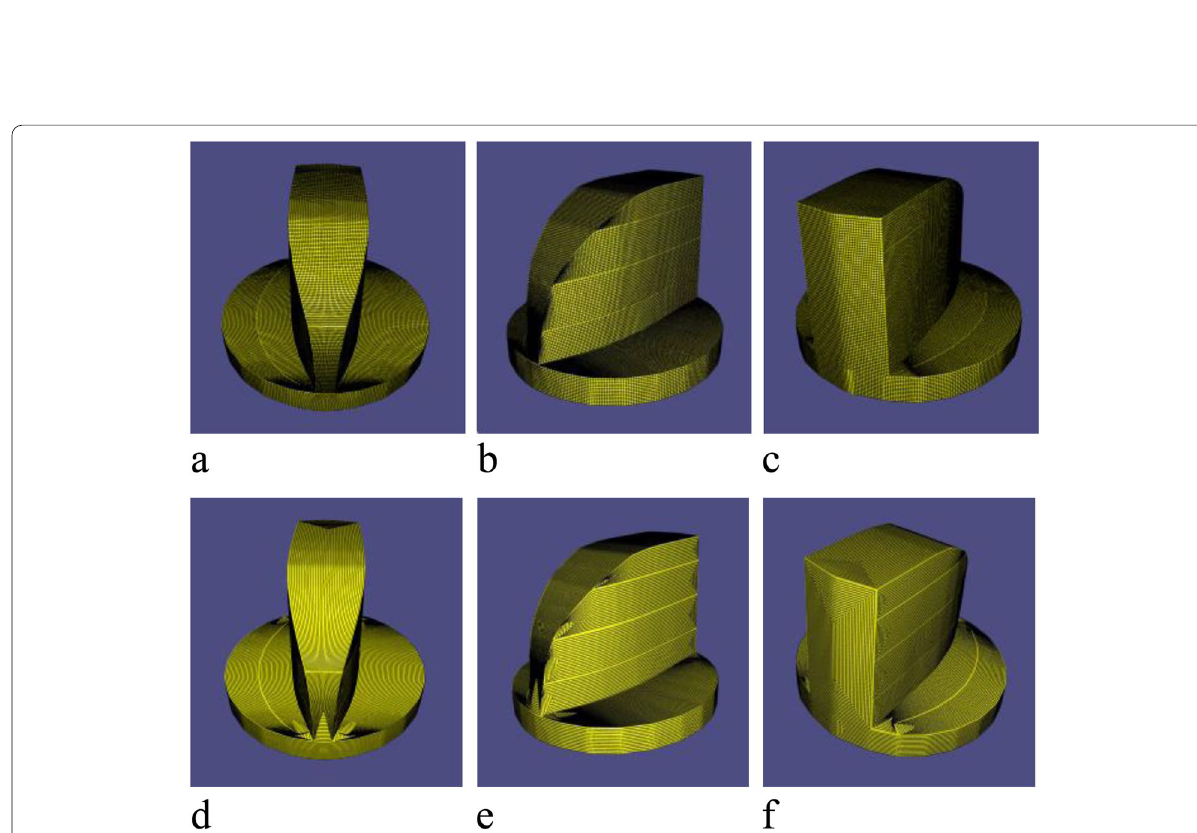
Fig. 20 Tool path of Spheredisk model: a ‑ c are model’s grid; d ‑ f are corresponding tool